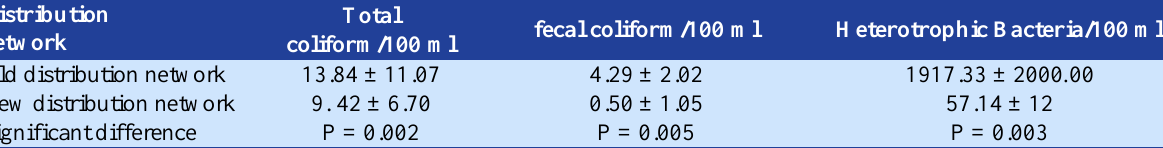
Table 1. Concentration of heterotrophic bacteria and coliforms (CFU/100 ml), in different distribution